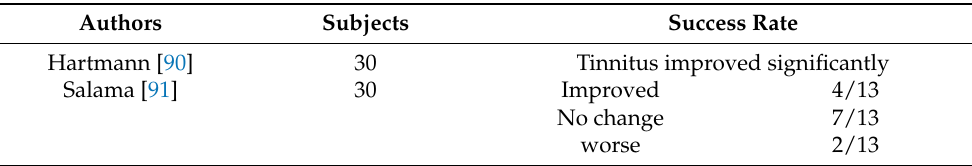
Table 12. Summary of studies that used pentoxifylline to treat tinnitus.